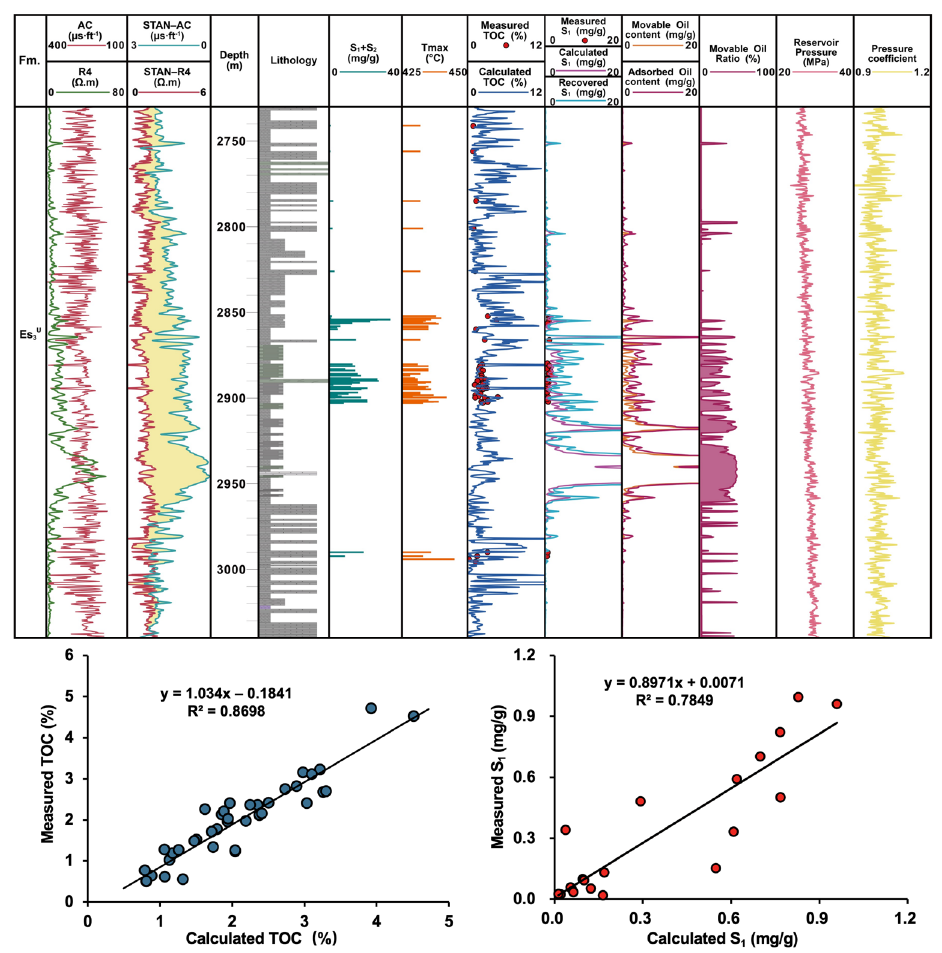
Figure 5. Evaluation results of organic geochemistry and pressure coefficient of shale reservoir and mobility of shale oil.